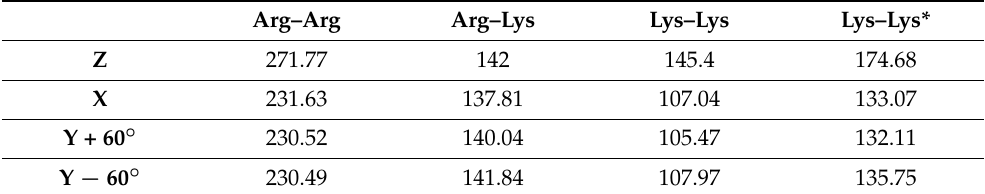
Table 3. Summary of the direction-dependent crystal strength modeled using the anisotropic inter- molecular cross-linking bonds. Adapted with permission from ref. [20]. Copyright © 2019, American Chemical Society.